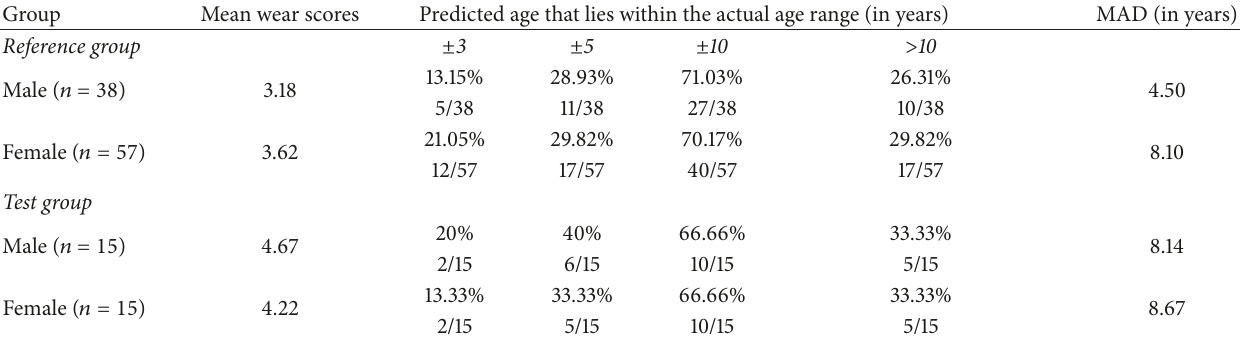
Table 8: Comparison of accuracy of linear equation in predicting the age of the individuals of the test group. Mean wear scores Predicted age that lies within the actual age range (in years)